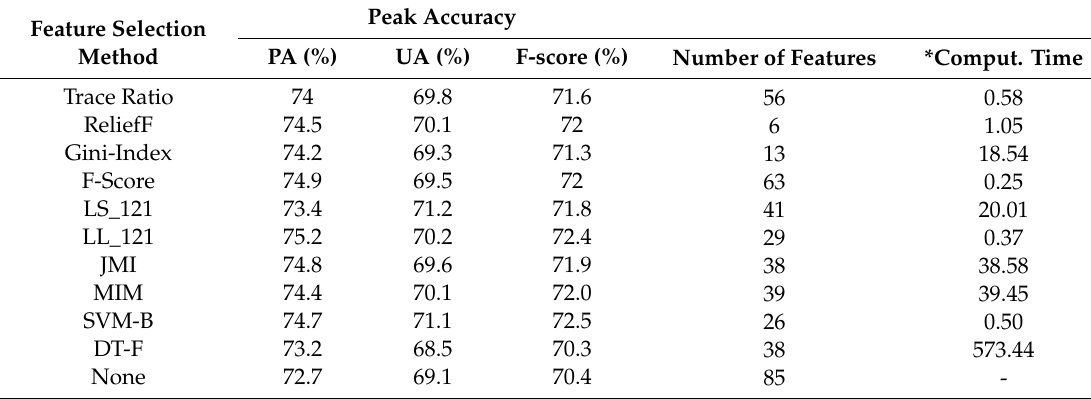
Table 3. Classification accuracies of other classes using optimal feature subsets yielded by investigated feature selection methods for first training set.